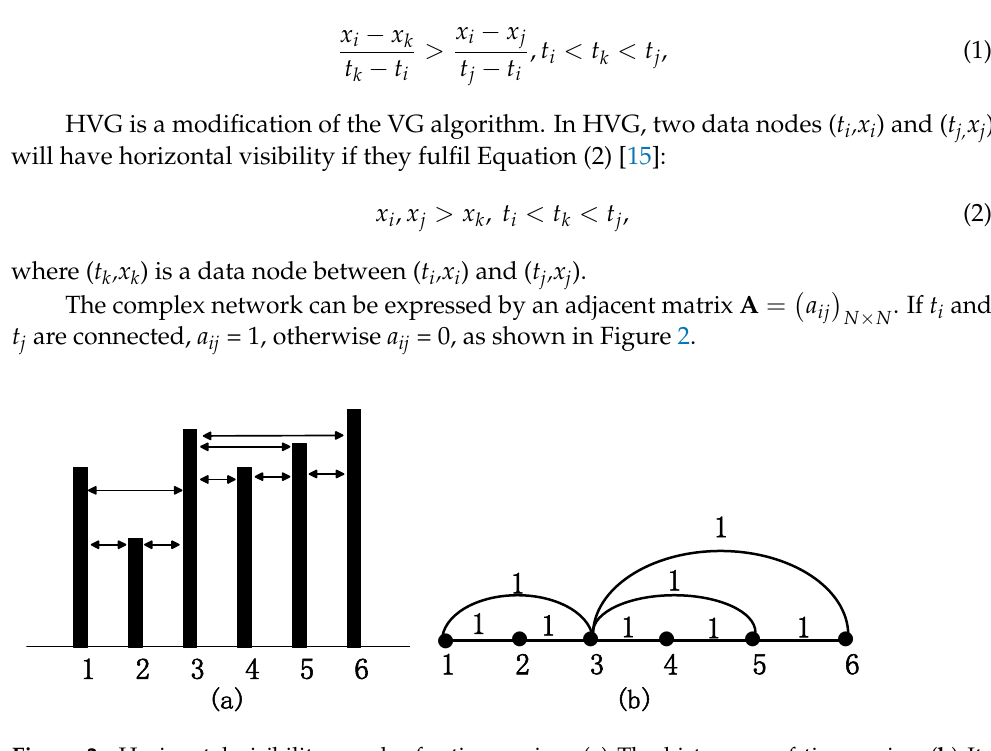
Figure 2. Horizontal visibility graph of a time series. ( a ) The histogram of time series; ( b ) Its corresponding HVG.